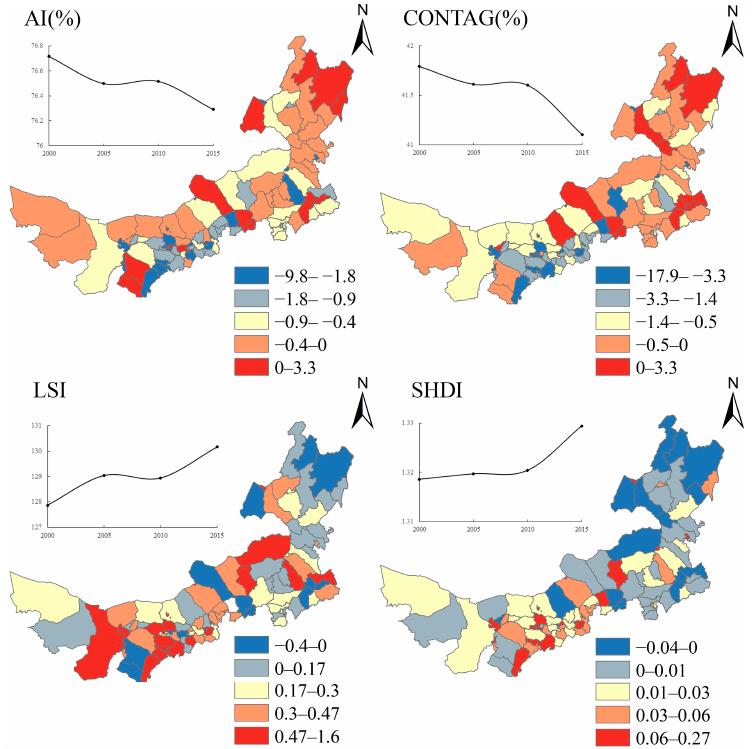
Figure 10. Changes in landscape metrics at the landscape level in Inner Mongolia from 2000 to 2015. Note: AI, aggregation index; CONTAG, contagion; LSI, landscape shape index; SHDI, Shannon’s diversity index.